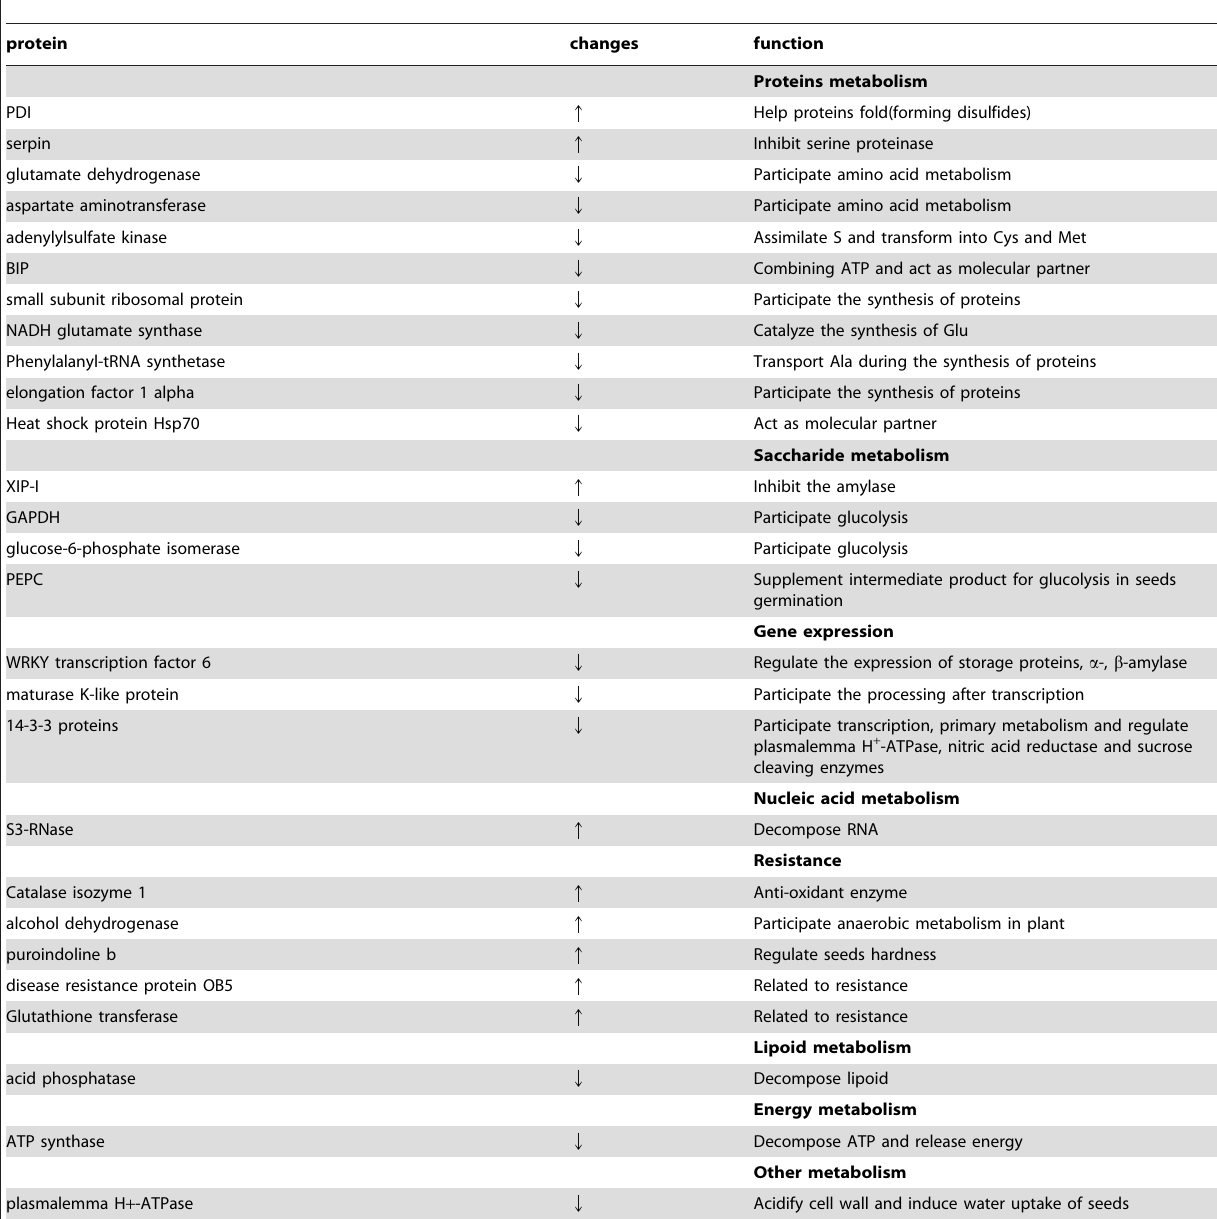
Table 4. Changes in wheat seeds proteins induced by anti-trx s gene.